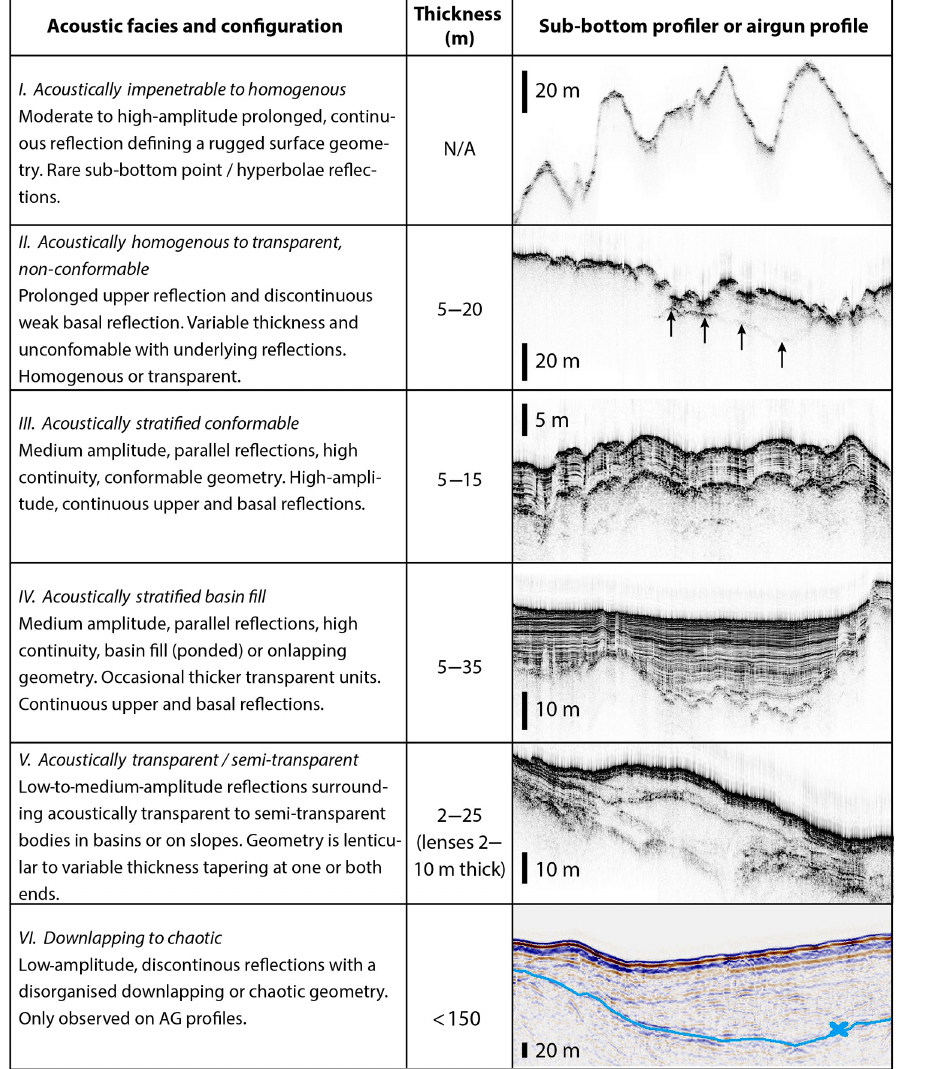
Figure 5. Seismo-acoustic facies identified from SBP profiles and AG profiles in Petermann Fjord and Nares Strait. Seismo-acoustic Facies I–V mapped primarily on SBP profiles and checked with AG profiles; Facies VI mapped only from AG